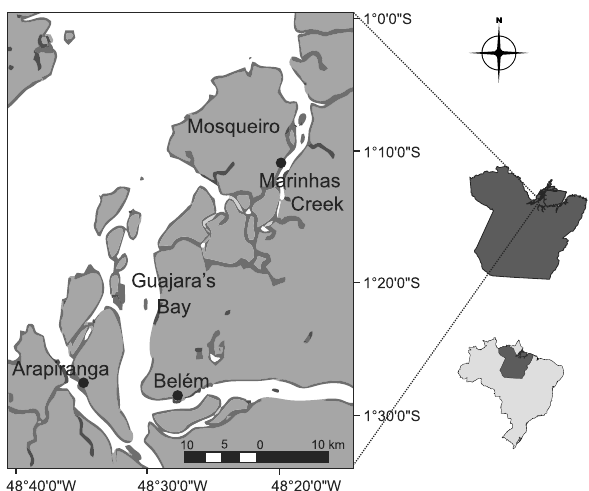
Figure 1. Map showing the sites of collection: Arapiranga Island and Mosqueiro Island (Furo das Marinhas), Amazon estuary of